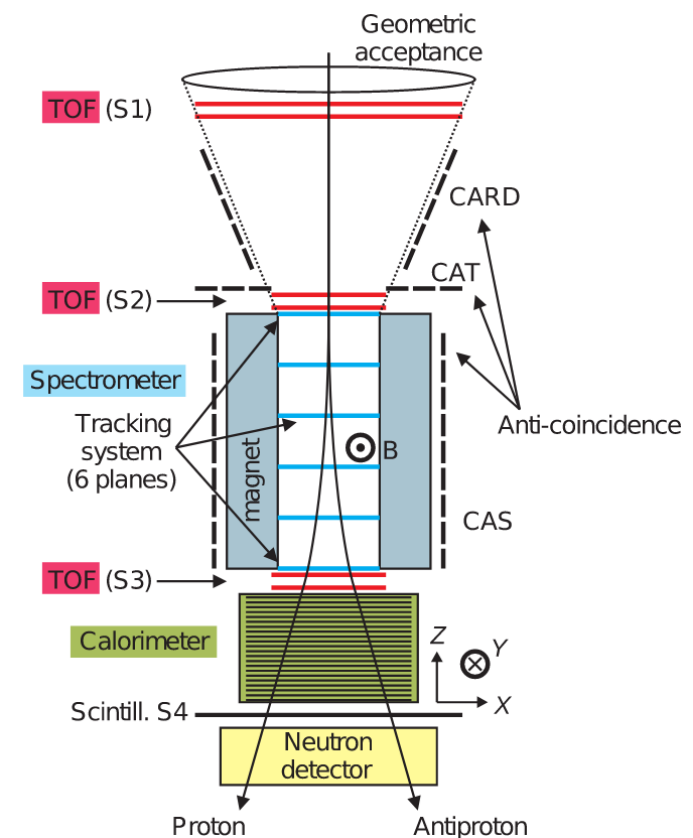
Figure 1. Scheme of the PAMELA detector. The spectrometer is 1.3 m high; the 0.43T permanent magnet is equipped with a silicon microstrip Tracker that provides rigidity up to 1TV and dE/dx information. A time of flight (ToF) detector, made of three pairs of plastic scintillators, can measure the velocity and charge of the particle. At its bottom, a silicon-tungsten imaging Calorimeter is able to provide a redundant β evaluation, for sub-relativistic particles, via dE/dx